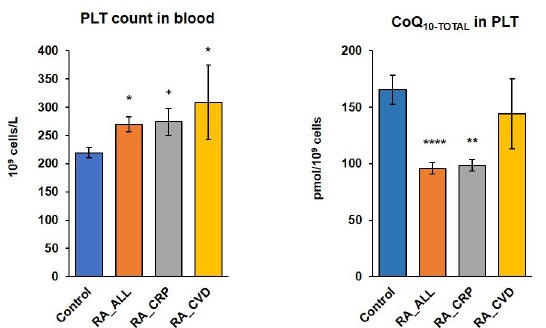
Fig 3. Platelet count and platelets coenzyme Q 10-TOTAL in control subjects and in groups of RA patients. CoQ 10-TOTAL (ubiquinol + ubiquinone); RA_ALL = all patients with rheumatoid arthritis; RA_CRP = rheumatic patients with high c-reactive protein concentration; RA_CVD = rheumatic patients with cardiovascular diseases; + p < 0.1 � p < 0.05; �� p < 0.01, ���� p < 0.0001.